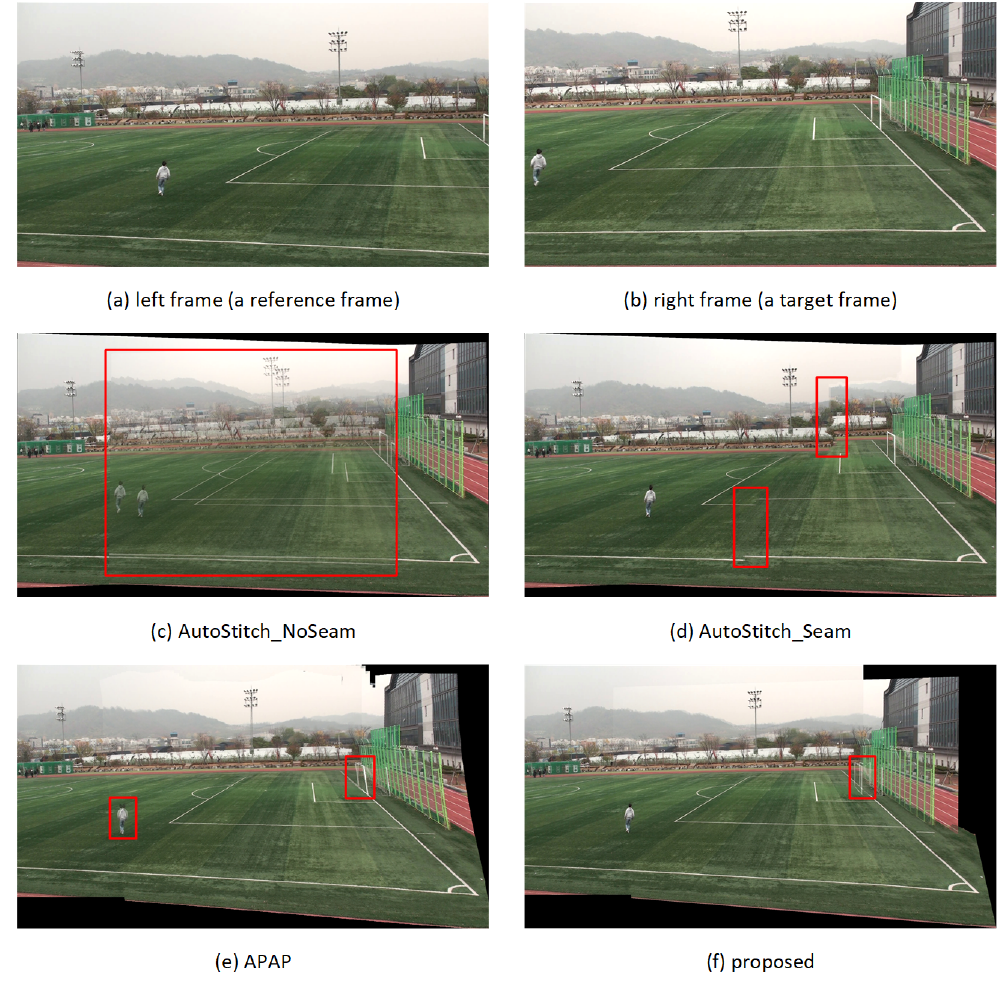
Figure 9. Quality comparison of stitched video frames: seq2